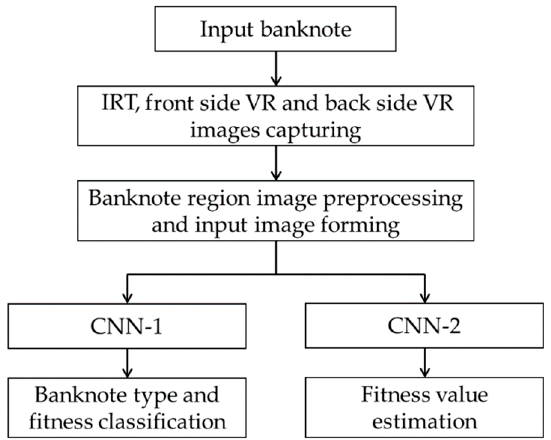
Figure 1. Overall flowchart of the proposed method.